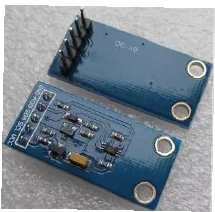
Figure 5. Light sensor BH1750FVI module physical map.